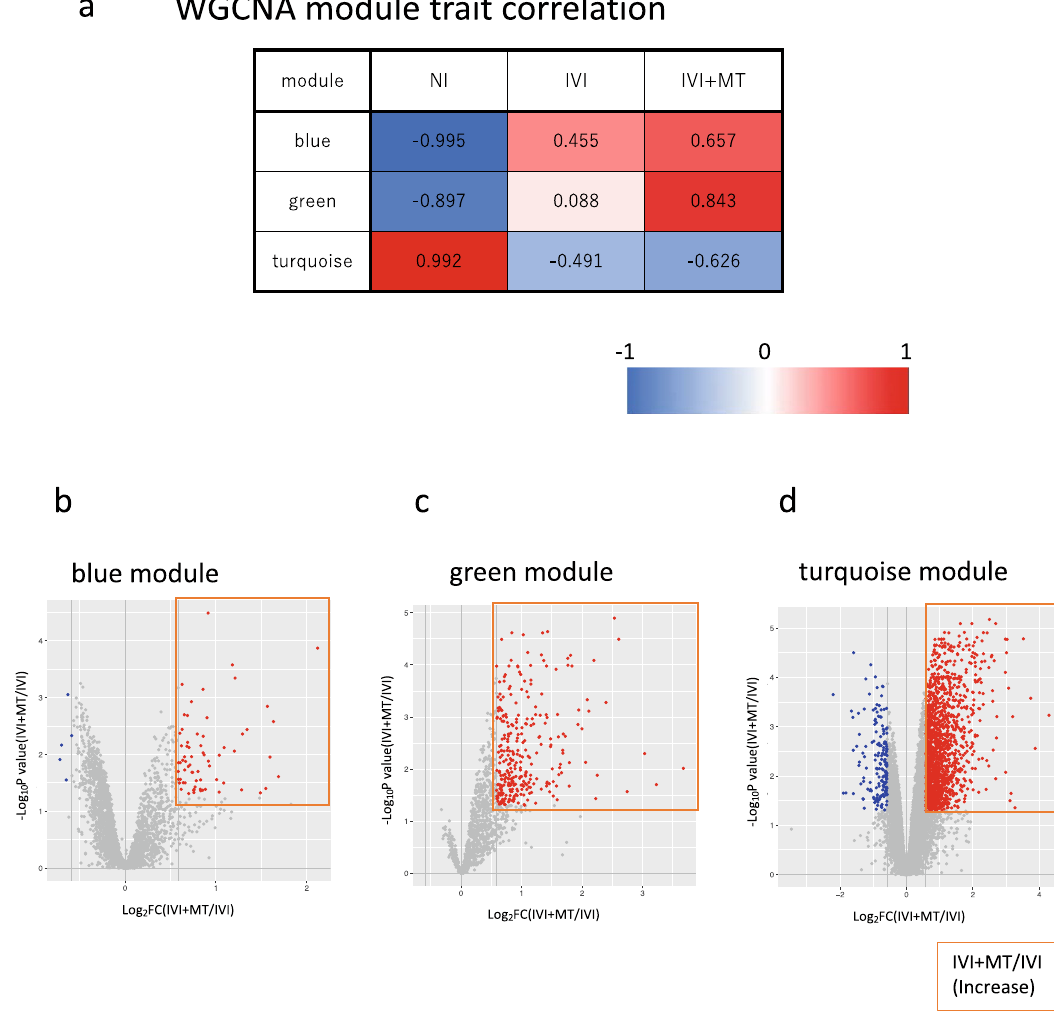
Figure 3. Weighted gene co-expression network analysis (WGCNA). ( a ) Correlation between module and trait. ( b – d ) Volcano plot for comparing gene expression between IVI + MT and IVI in the blue, green, and turquoise modules. Blue indicates a significant decrease in gene expression in IVI + MT relative to IVI at P < 0.05 and fold change (FC) < 0.67; red indicates a significant increase in gene expression in IVI + MT relative to IVI at P < 0.05 and FC > 1.5. ( e ) Summary of cell type enrichment analysis (CTen). –log 10 Benjamini–Hochberg adjusted P > 2 was considered to be significant. For each module, the left column shows the results using all genes in the module; the right column shows the results using genes significantly increased by MT relative to IVI. ( f ) Pathway enrichment analysis of differentially expressed genes between IVI and NI in the blue (FDR < 0.05) ( f1 ) and green (major top 7 pathways with FDR < 0.05) ( f2 ) modules. The gene sets significantly increased by IVI relative to NI at criteria of P < 0.05 and log 2 FC > 3 were used for analysis. ( g ) Pathway enrichment analysis of differentially expressed genes between IVI + MT and IVI in the green (FDR < 0.05) ( g1 ) and turquoise (FDR < 0.05) ( g2 ) modules. The gene sets significantly increased by MT relative to IVI at criteria of P < 0.05 and FC > 1.5 were used for